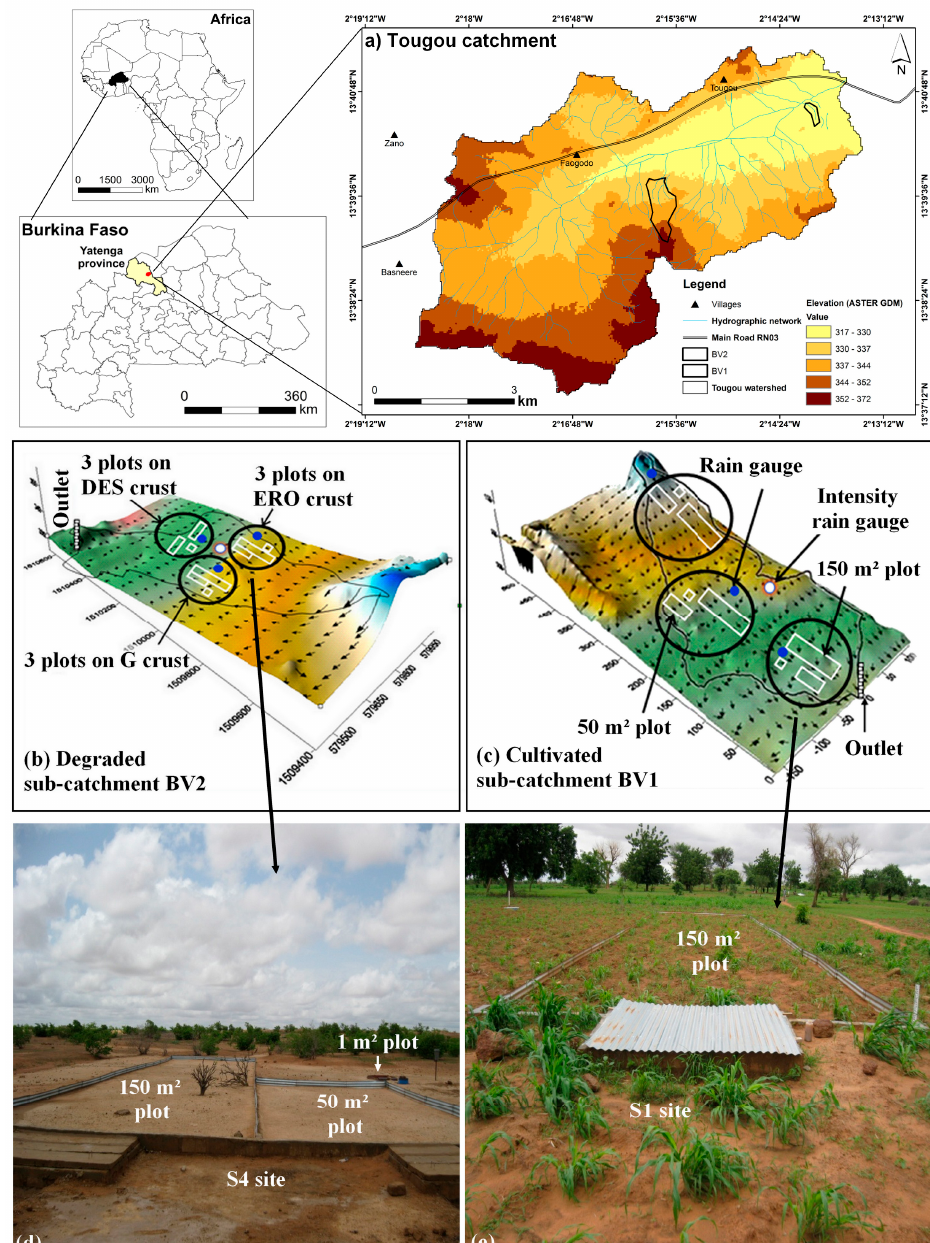
Figure 1. The experimental design used in the present study and the location of the Tougou watershed. ( a ) Location of Tougou watershed in Burkina Faso. The black contour lines indicate the locations of the sub-watersheds BV1 (which is cultivated) and BV2 (with bare and degraded soils). The ASTER GDEM Digital Elevation Model, 30 m resolution, tile number N13W003, obtained from USGS Earth Explorer (https://gdemdl.aster.jspacesystems.or.jp/index_en.html (accessed on 12 September 2020)), is used to calculate the elevation for the entire watershed. ( b ) Detailed representation of the experimental design in BV2. ( c ) Detailed representation of the experimental design in BV1. ( d ) Field images of the experimental design at S4 site in BV2. ( e ) Field images of the experimental design at S1 site in